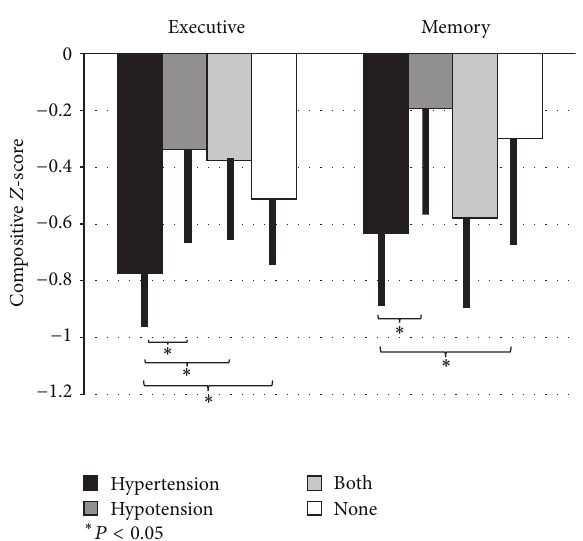
Figure 2: Executive and verbal memory composite scores in four blood pressure groups; hypertensive, hypotension, cooccurring hypertension and hypotension (both), and normotensive (none). Figure depicts mean composite Z -scores for executive function and delayed verbal memory across each of the blood pressure groups. For executive function , Parkinson’s patients with hypertension alone ( X = − 0.781, SD = 0.769) performed significantly worse than those with hypotension alone ( X = − 0.321, SD = 0.769, t = − 2.87, 𝑃 = 0.004 ), combined hypertension-hypotension ( X = − 0.437, SD = 0.739, t = − 2.50, 𝑃 = 0.013 ), and normotensive/none ( X = − 0.495, SD = 0.898, t = − 2.21, 𝑃 = 0.028 ). For delayed verbal memory , Parkinson’s patients with hypertension alone ( X = − 0.633, SD = 1.068) performed significantly worse than those with hypotension alone ( X = − 0.194, SD = 1.098, t = − 2.45, 𝑃 = 0.015 ) and the normotensive/none group ( X = − 0.301, SD = 1.013, t = − 2.23, 𝑃 = 0.026 ). There were no differences in memory between the hypertension and the combined hypertension-hypotension